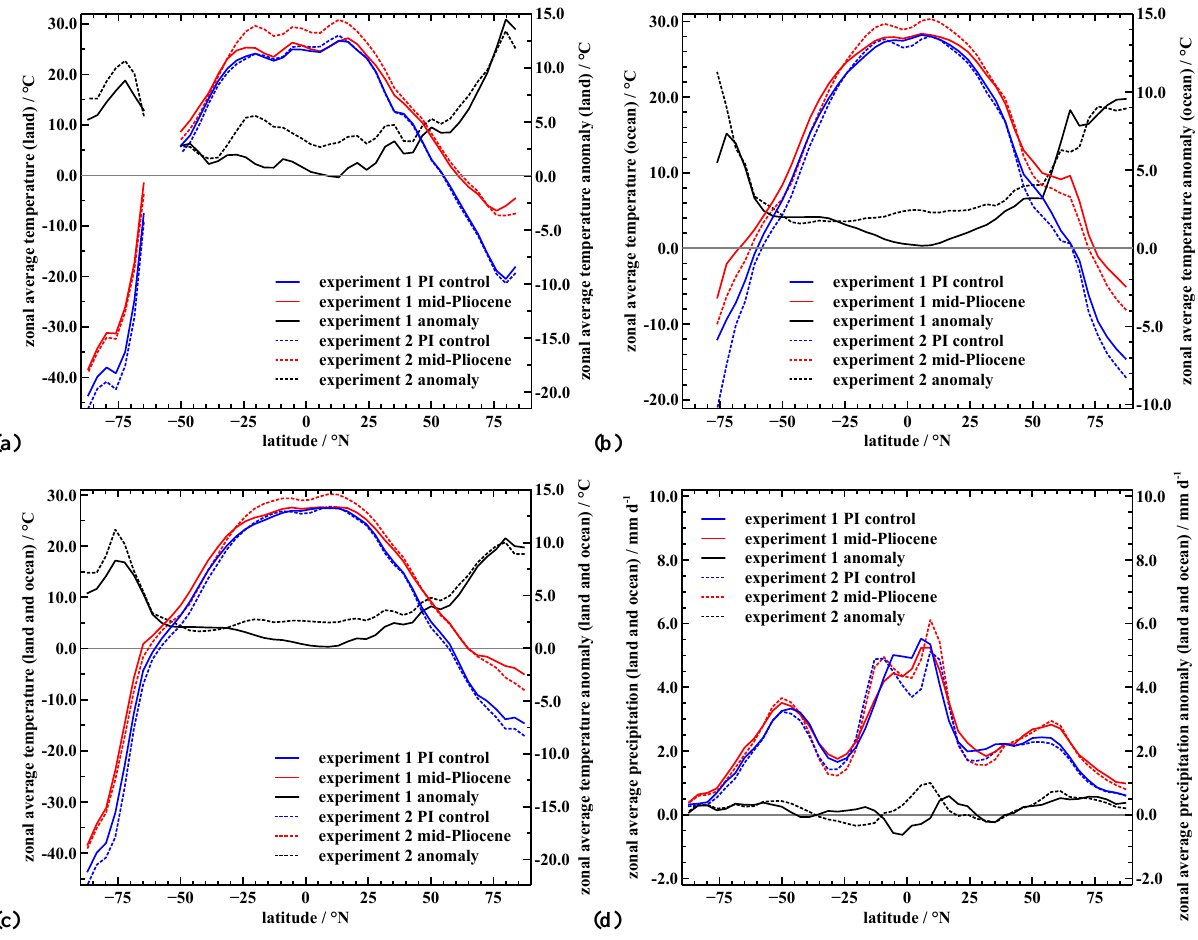
Fig. 7. Zonal averages and average anomalies of SAT in ◦ C for land areas (a) , oceans (b) , and land and ocean (c) . Shown are absolute values for the PI control and mid-Pliocene simulations of experiments 1 and 2, as well as the respective anomalies. Zonal averages and average anomalies of precipitation for land and ocean (d) . All values have been retrieved from a 30-yr